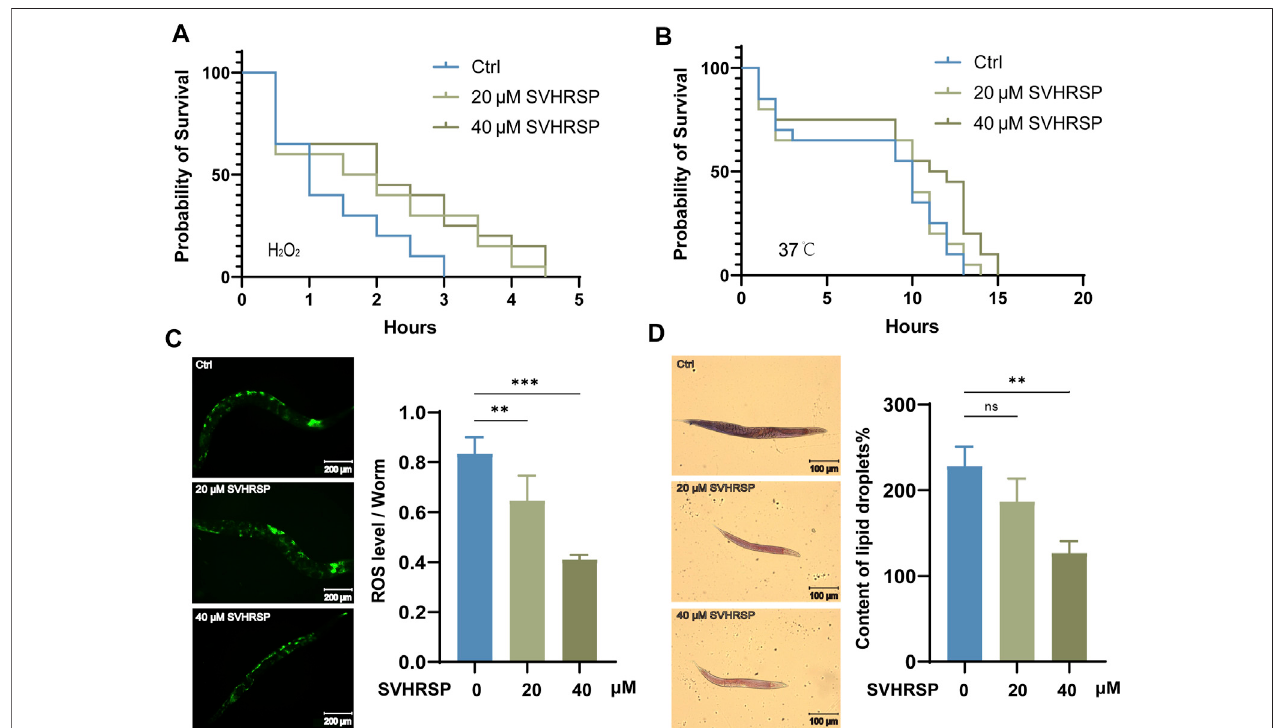
FIGURE 2| Scorpion venom heat – resistant synthesized peptide (SVHRSP) signi fi cantly increased the resistance of nematodes tostress. (A) mean survivaltimeof wild-type worms treated with 20- and 40- μ M SVHRSP at 30% H 2 O 2 . Log-rank veri fi es the calculated p -value. * p < 0.05 (B) the mean survival time of wild-type worms treatedwith20-and40- μ MSVHRSPat37 ° C.Log-rankveri fi esthecalculated p -value.* p < 0.05 (C) effectsof20-and40- μ MSVHRSPonreactiveoxygenspecieslevels in wild-type worms. (D) the effect of SVHRSP on fat accumulation. SVHRSP signi fi cantly inhibited the accumulation of excess fat in N 2 nematodes. Values are presented as mean ± SEM. All of these measurements were made at least three times. Log-rank and one-way analysis of variance veri fi es the calculated p -value. ns means none signi fi cant; * p < 0.05; ** p < 0.01; *** p <